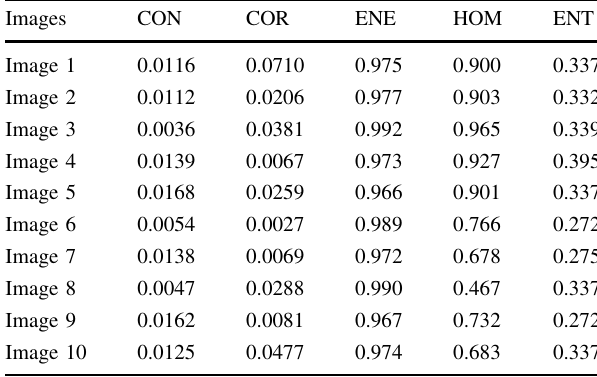
Table 1 The statistical features obtained from gray-level co-occur- rence matrix (GLCM) of LL and HL subbands of trained images